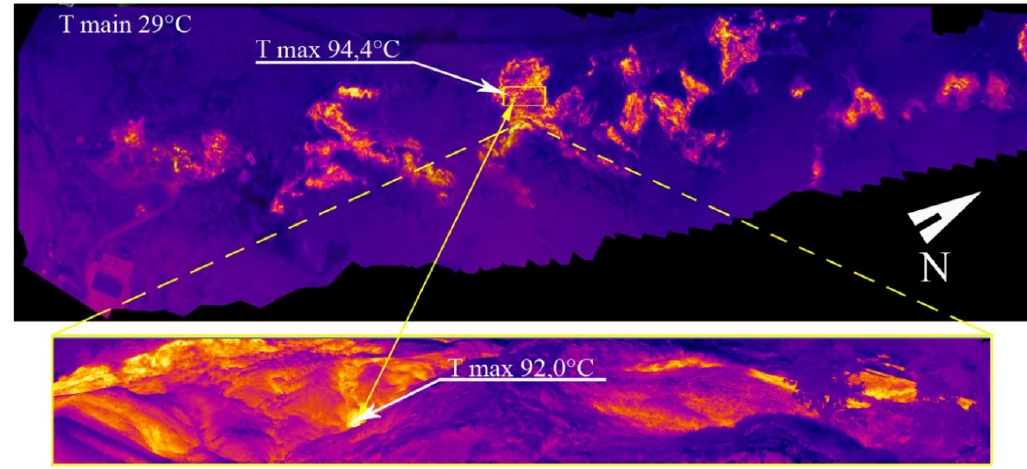
Figure 7. Thermal mapping from UAV flight ( above ) and from hand-held thermal camera ( below ) of 19 June 2019 on the Parco delle Biancane.